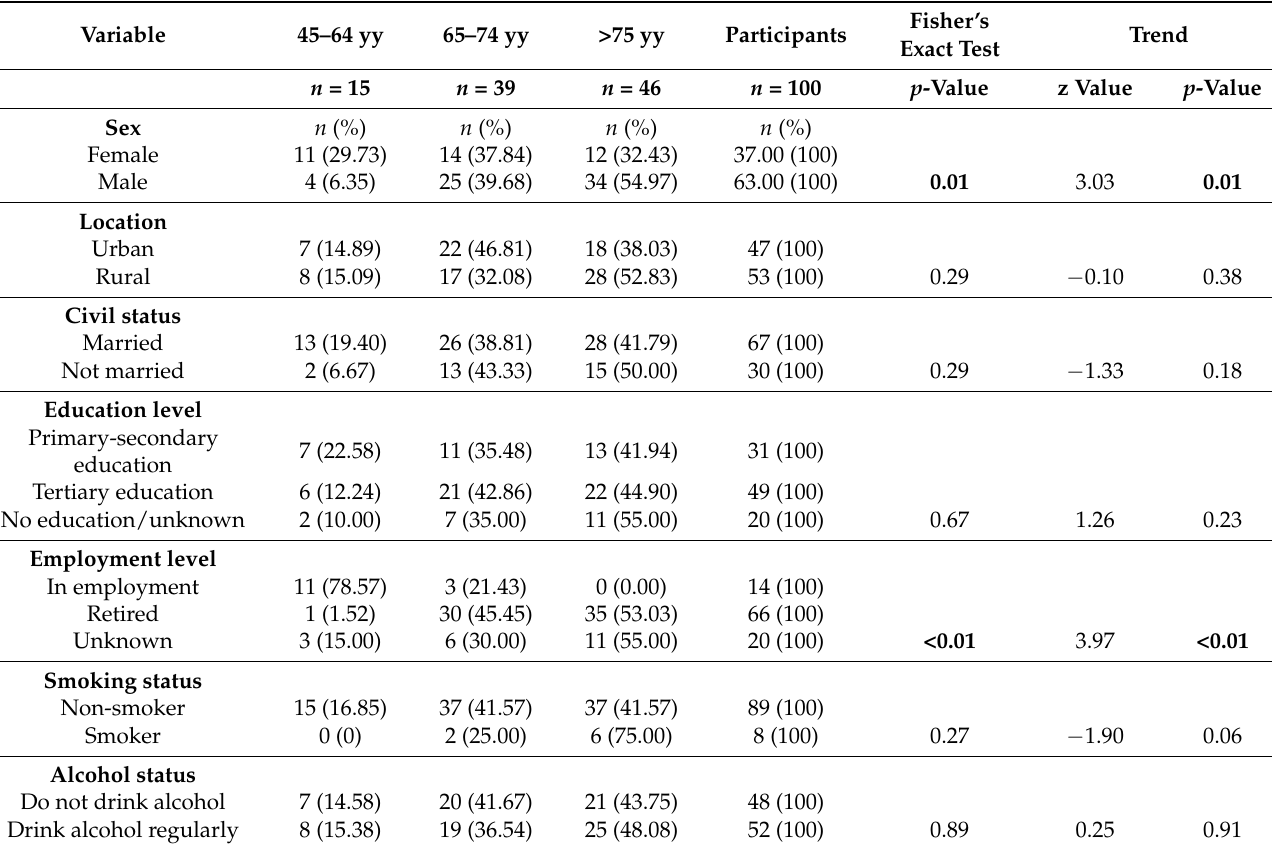
Table 1. Participant characteristics among the three different age